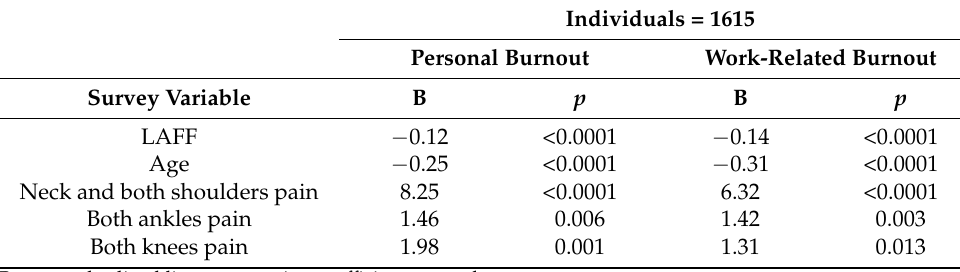
Table 2. Univariate Linear Regression of Survey Variables against PB/WB.